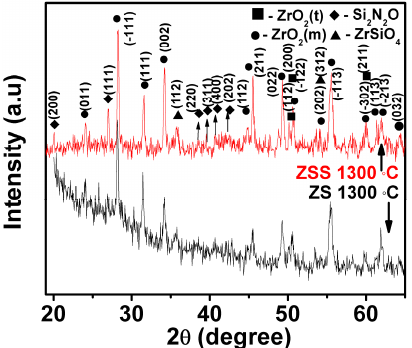
Figure 3. XRD patterns obtained from the oxide scales formed on the ZS and ZSS composites after isothermal oxidation at 1300 °C for 100 h in air. Comparison of peak intensities reveals that ZrO 2 (m) is the major constituent, whereas ZrO 2 (t) and ZrSiO 4 are the minor constituents of the oxide scales. Evidence of Si 2 N 2 O peaks is noted for the ZSS composite.